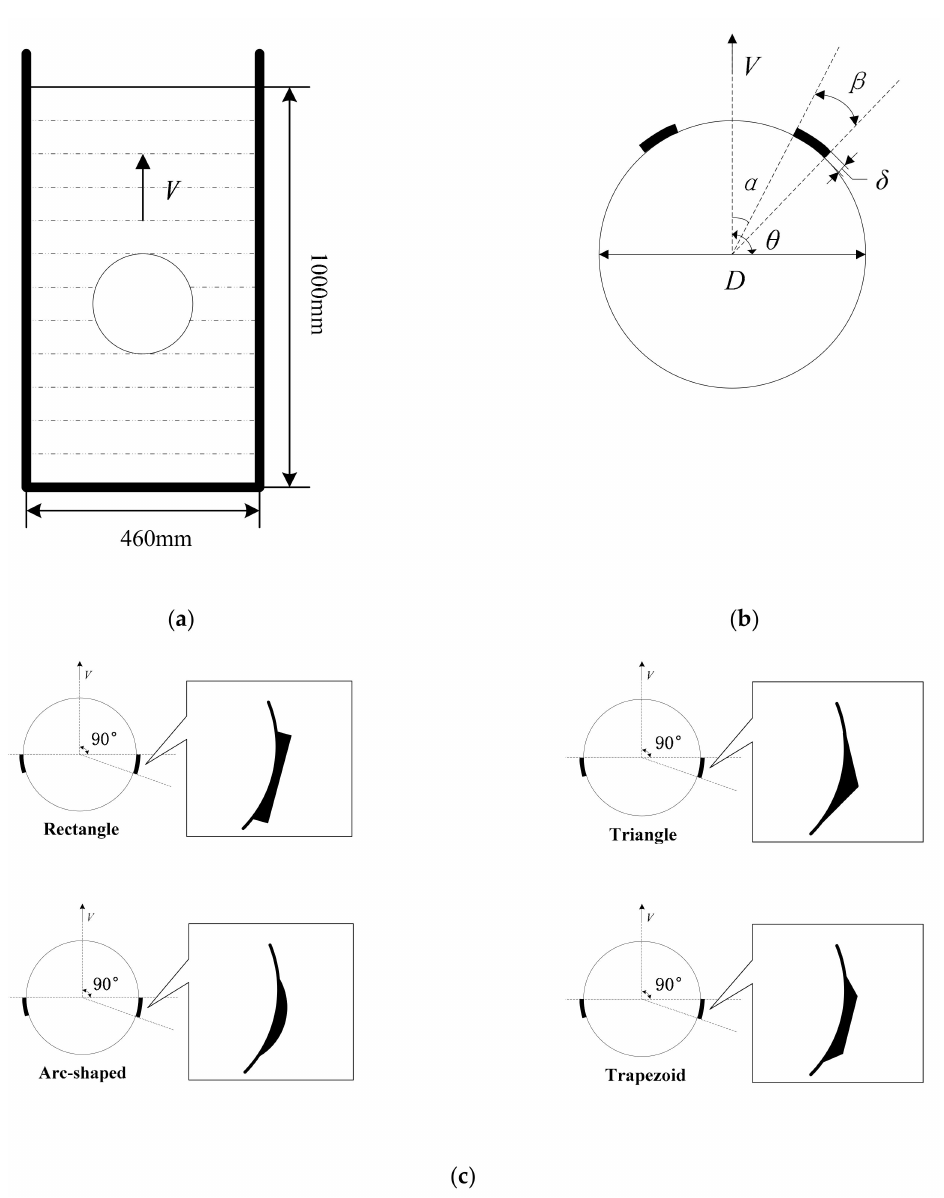
Figure 1. Schematic diagram of the structure of the cylinder with two symmetric strips: ( a ) physical model; ( b ) the specific distribution of a pair of strips; and ( c ) strips of di ff erent